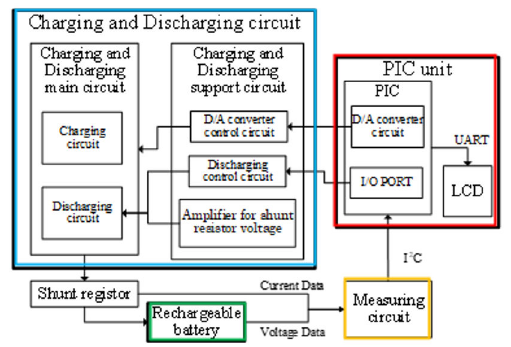
Figure 1. Block diagram of the charging / discharging circuit.